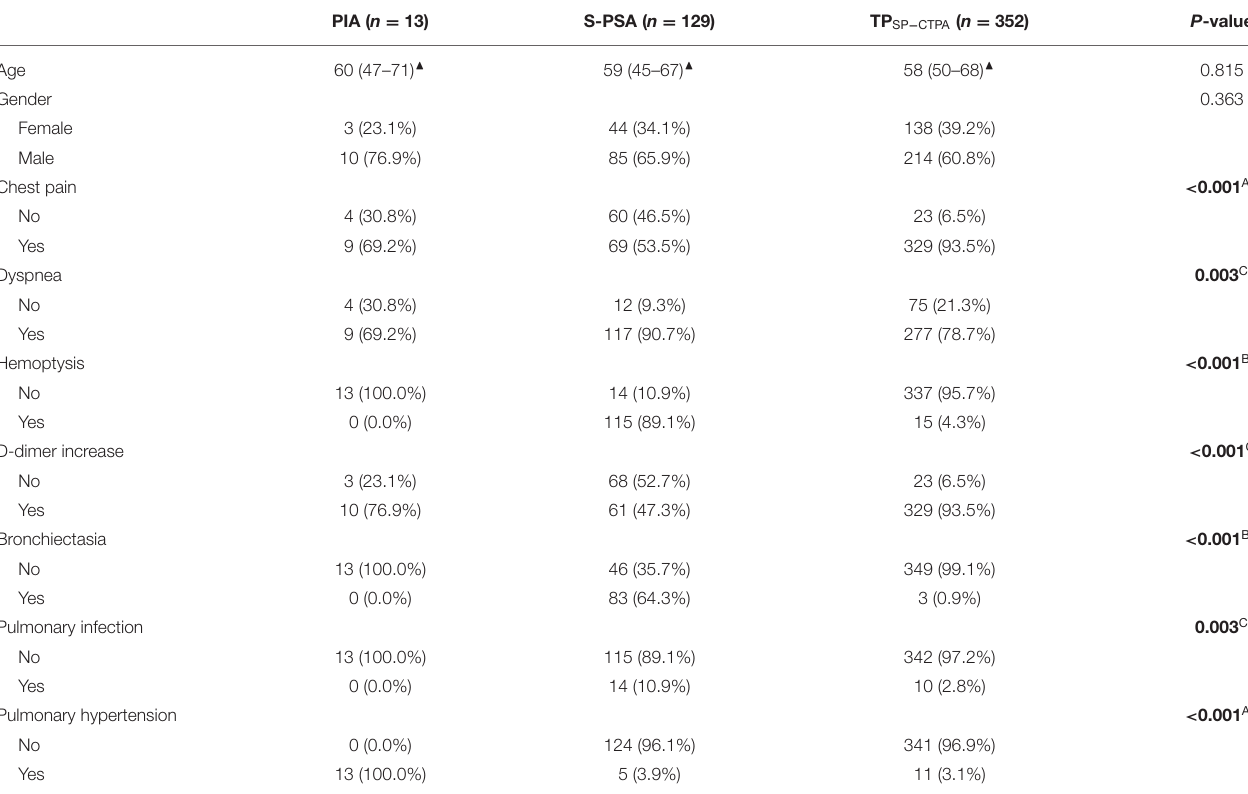
TABLE 3 | Comparison of basic data of PIA, S-PSA and TP SP − CTPA groups.